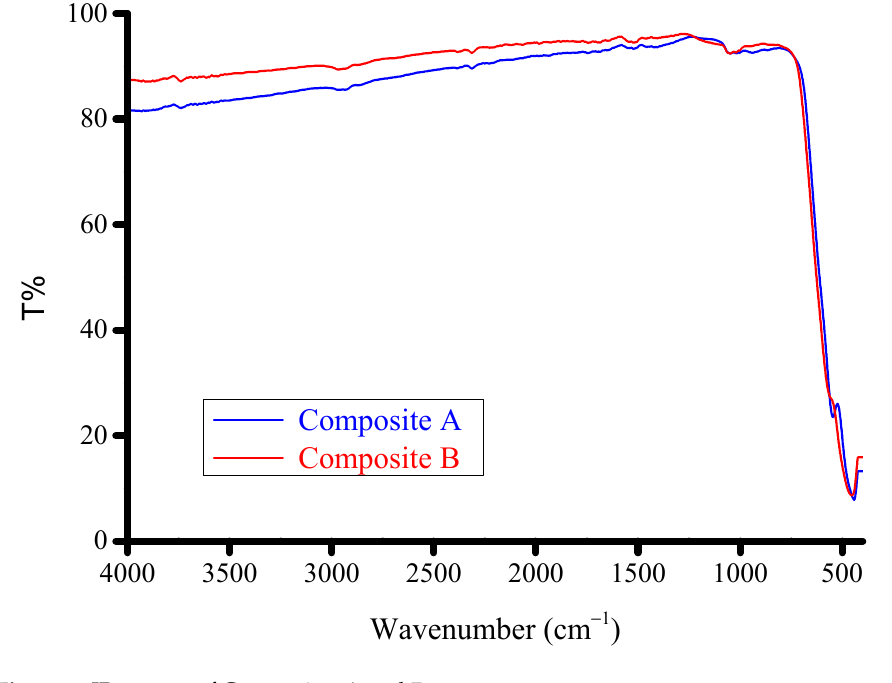
Figure 3. IR spectra of Composites A and B .